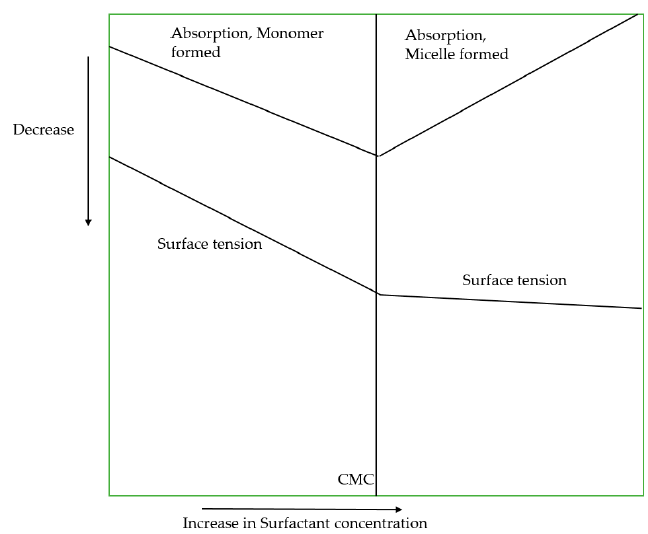
Figure 16. Trend in key active mechanism applied in surfactant to understand the effect of SDS concentration.